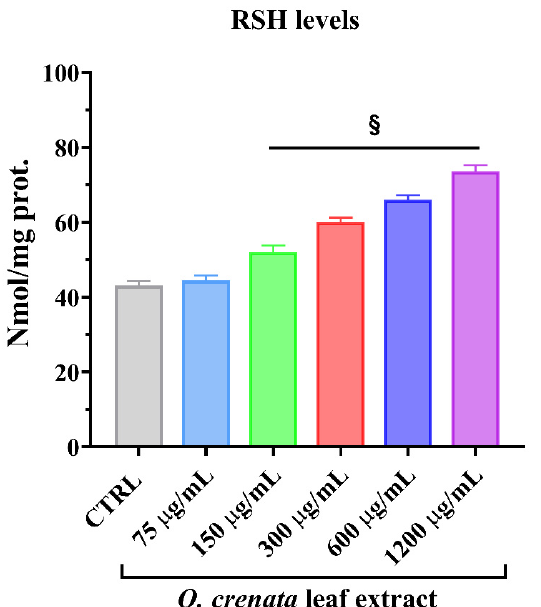
Figure 5. Thiol groups in MCF-7 cells untreated and treated for 24 h with different concentrations (75–1200 µg/mL) of O. crenata leaf extract. Values are the mean ± SD of four experiments in triplicate. § p < 0.0001 vs. untreated control (CTRL).